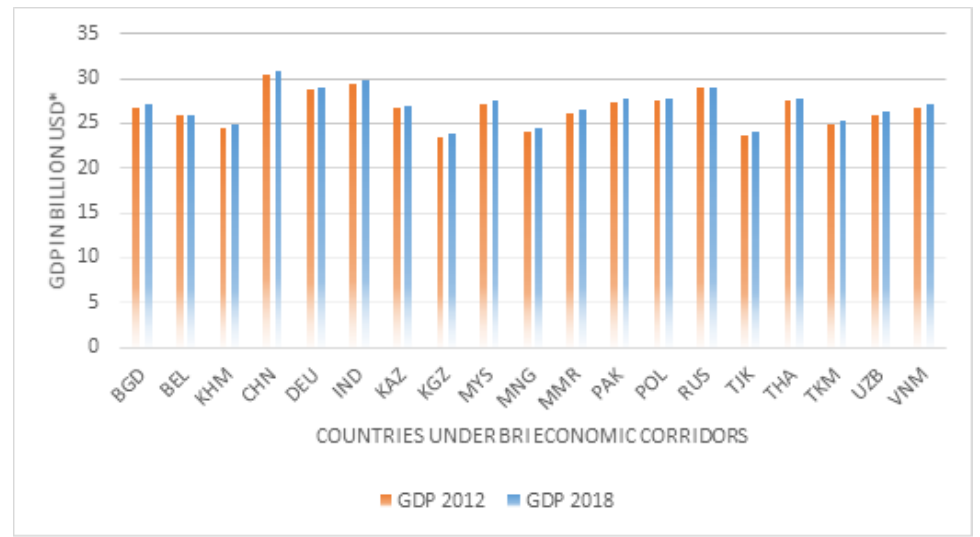
Figure 1. GDP of countries under six economic corridors at pre- and post-BRI (Belt and Road initiative) stages. Source: The World Bank.